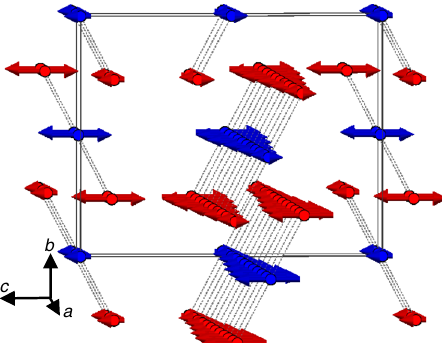
Fig. 8 Incommensurate magnetic structure of CaFe 3 O 5 . Schematic of the modulation of the moment in the incommensurately ordered regime of CaFe 3 O 5 (CO) with moments joined by dotted lines representing the trimerons. The k -vector has been exaggerated slightly to ~0.52 to shorten the period of the wave along a for ease of display. (Fe1: red,